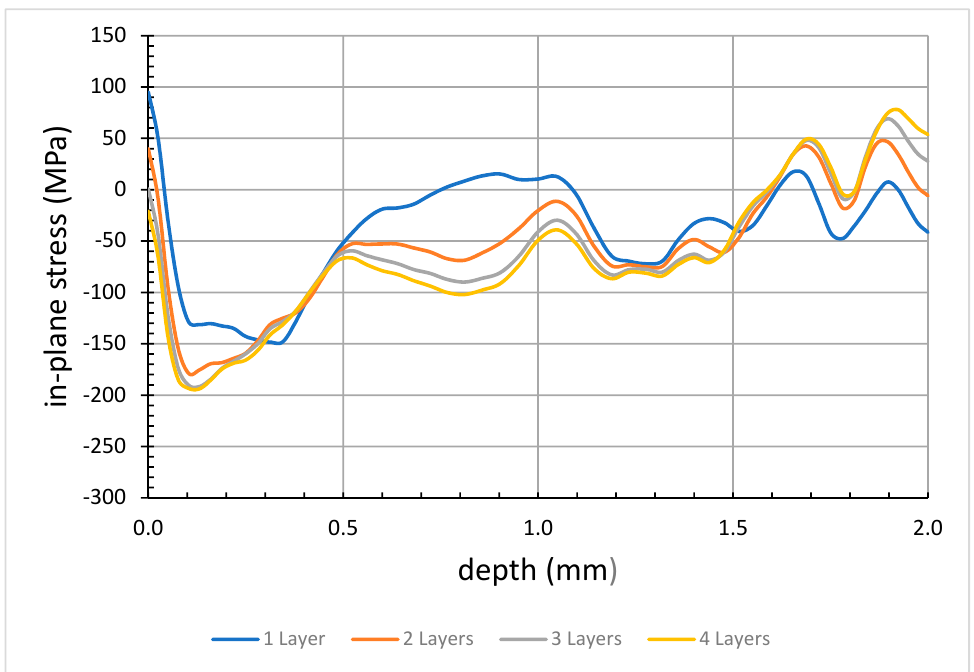
Figure 6. Effect of peen layering on predicted in-plane residual stress in thin sections (single square LP shot, 5 × 5 mm 2 , on a 2-mm-thick Al2024-T351 plate).